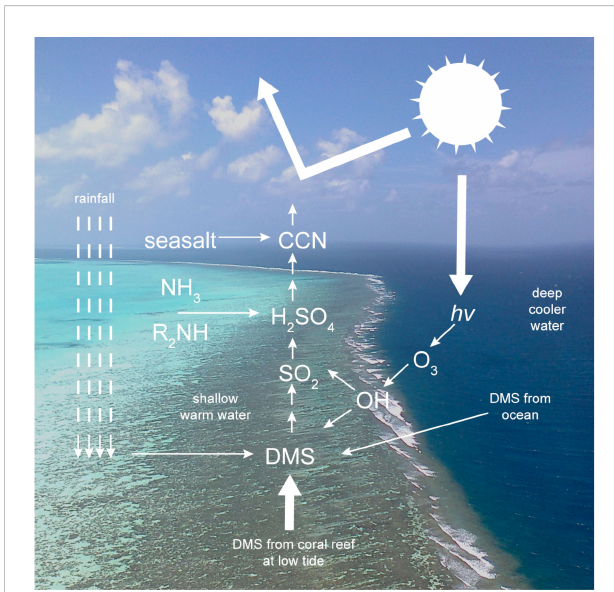
FIGURE 1 An aerial photograph of Wistari Reef near Heron Island in the Capricorn – Bunker group of coral reefs southern Great Barrier Reef, Australia (23.13° S, 151.85° E to 23.92° S, 152.60° E). Superimposed on this image is a conceptual model of factors controlling hygroscopic sulfate aerosol production (H 2 SO 4 ) over the GBR. Ocean-derived atmospheric DMS and pulses of atmospheric DMS from the coral reef at low tide are oxidised by photochemically produced hydroxyl radical (OH) forming sulfate aerosol that can grow to cloud condensation nuclei (CCN). This process can assist formation of high-albedo low- level marine clouds that in fl uence solar radiation over the GBR. Source: Hilton B. Swan, Graham B. Jones, Elisabeth S. M. Deschaseaux, and Bradley D. Eyre. Biogeosciences, 14, 229 – 239, 2017 www.biogeosciences.net/14/229/2017/doi:10.5194/bg-14-229-2017 © Authors 2017. CC Attribution 3.0